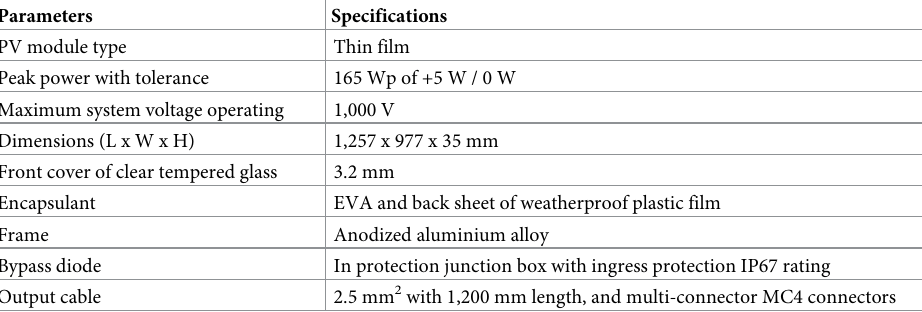
Table 2. PV modules